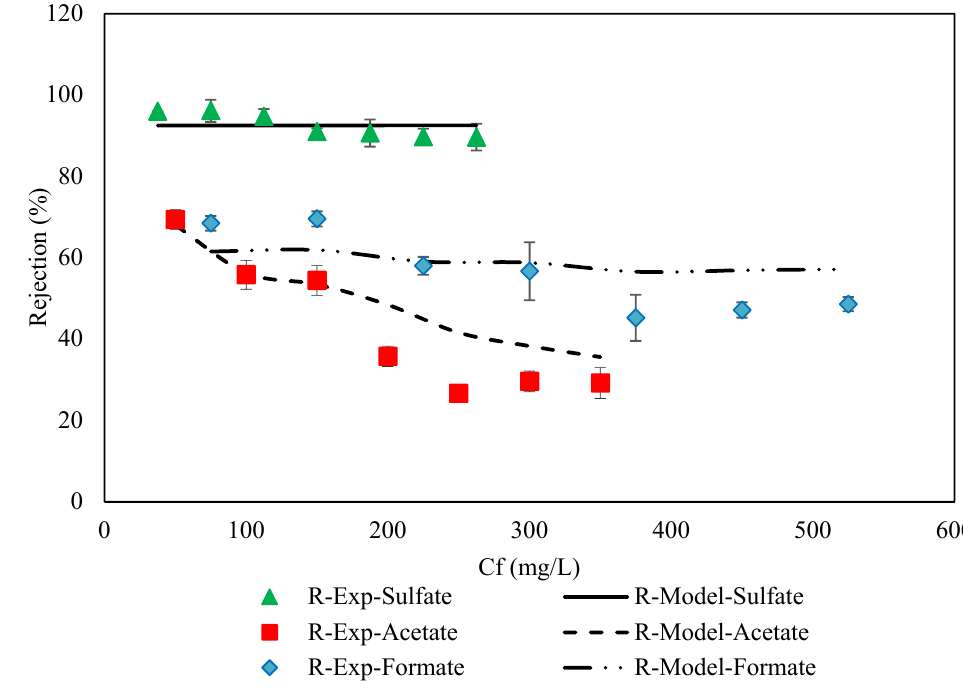
Figure 5. Comparison of the experimental data with the obtained results of the mathematical equations reported for acetate, formate, and sulfate in the NF-3 membrane at 35 °C and 70 bar.